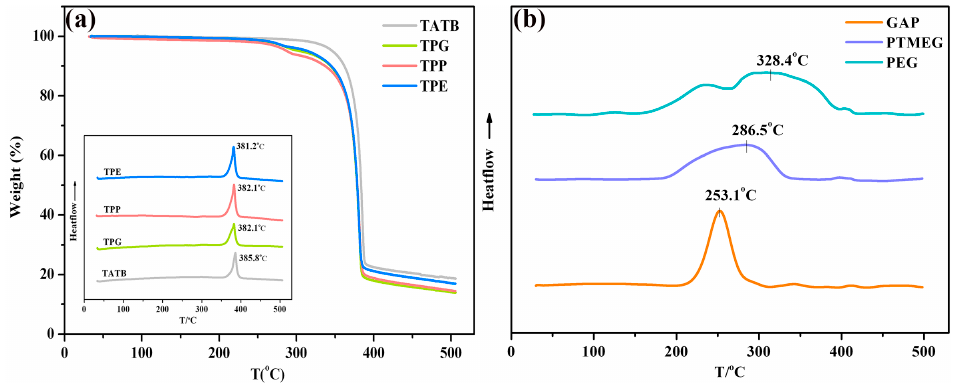
Figure 7. ( a ) Thermogravimetric analysis (TGA) curves of TATB with and without grafting; the inset shows the differential scanning calorimetry (DSC) curves; ( b ) DSC curves of GAP, PTMEG, and PEG polymers.